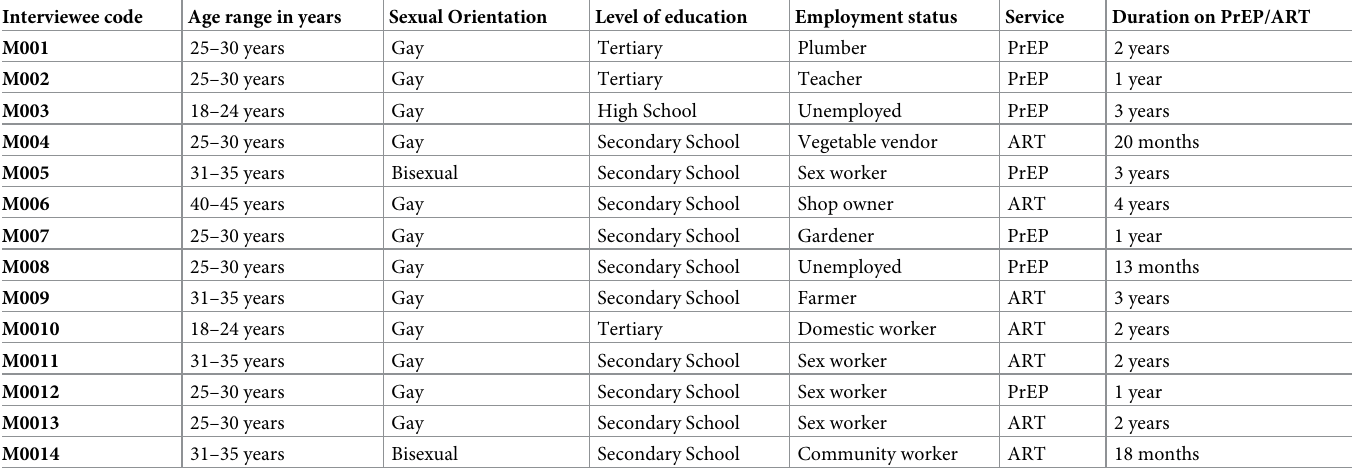
Table 1. Demographic and service-related characteristics of study participants. Interviewee